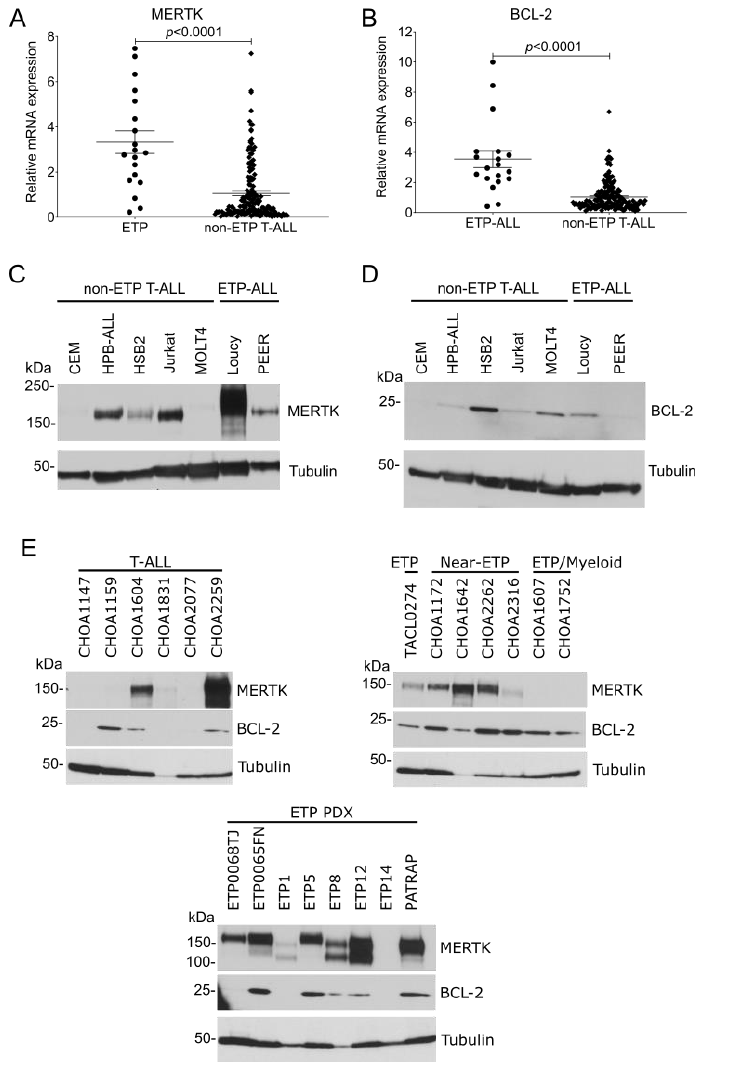
Figure 1. MERTK and BCL-2 mRNA and protein are preferentially expressed in ETP-ALL compared to non-ETP T-ALL. ( A , B ) Publicly available gene expression data from the TARGET program were analyzed to determine the relative expression of MERTK ( A ) or BCL-2 ( B ) in pediatric ETP-ALL and non-ETP T-ALL patient samples. mRNA read counts were normalized to the mean mRNA read count in the non-ETP T-ALL samples and the distribution was compared using an unpaired t -test. ( C , D ) Whole-cell lysates from a panel of T-ALL and ETP-ALL cell lines were probed for MERTK ( C ) or BCL-2 ( D ) expression by immunoblot. Tubulin was used as a loading control. Images shown are representative of at least three independent experiments. ( E ) Whole-cell lysates of primary samples from patients with T-ALL (left panel) or ETP-ALL, near-ETP, and ETP/Myeloid ALL (right panel) or from xenograft-passaged ETP-ALL patient samples (ETP PDX, bottom panel) were probed for MERTK and BCL-2. Tubulin was used as a loading control.